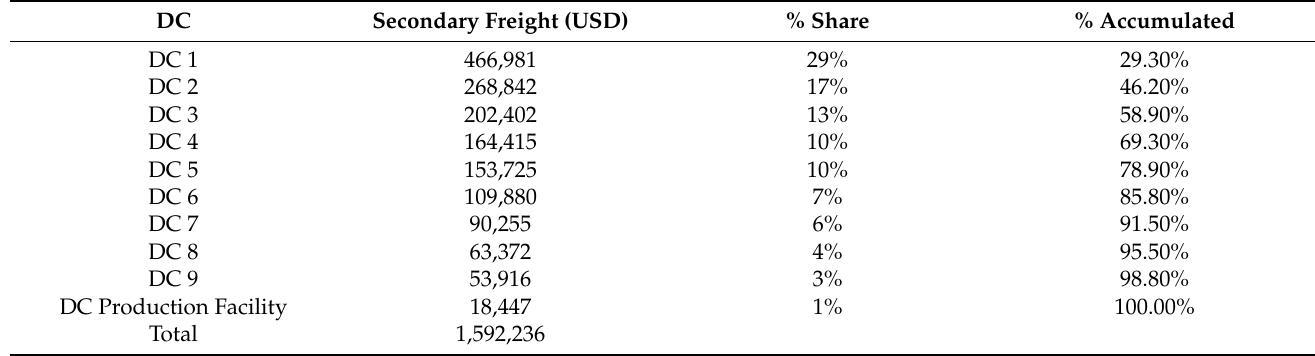
Table 4. Secondary freight